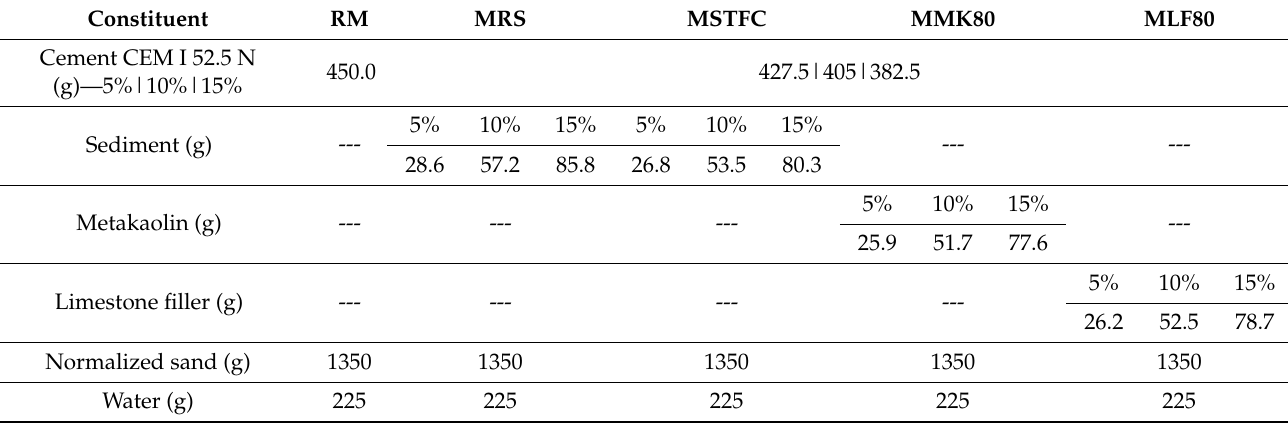
Table 1. Mortar composition of RM, MRS, MSTDC, and MSTFC for the heat of hydration test (NF EN 196-9)